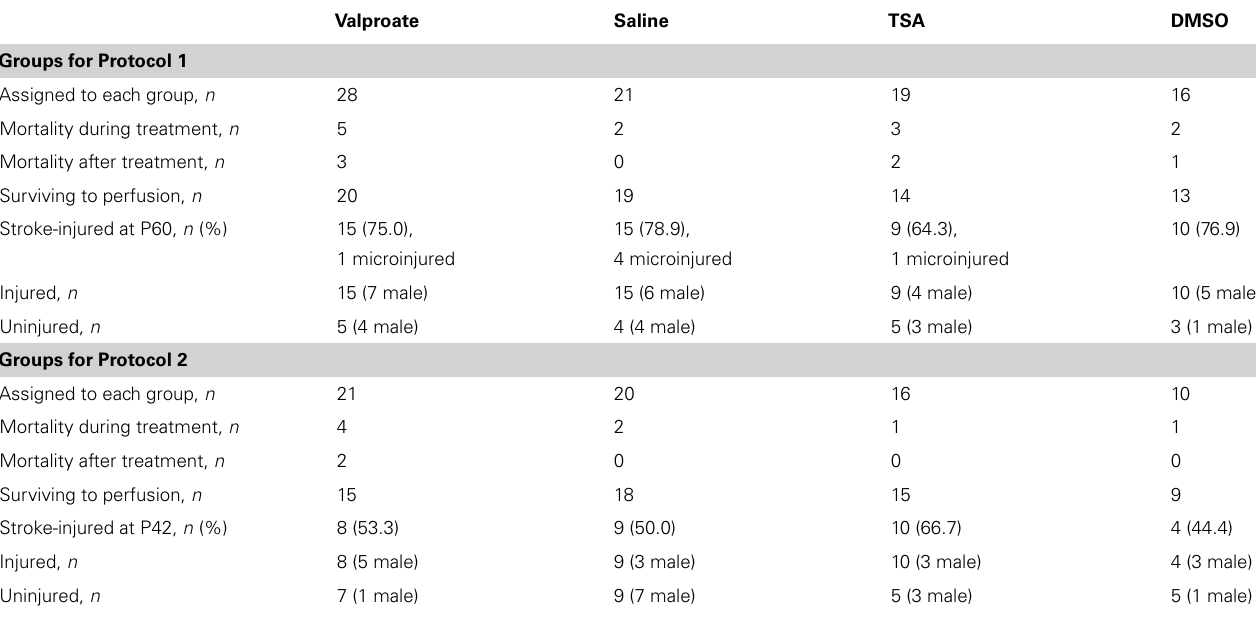
Table 1 | Numbers of ligated mice for each set of experiments.